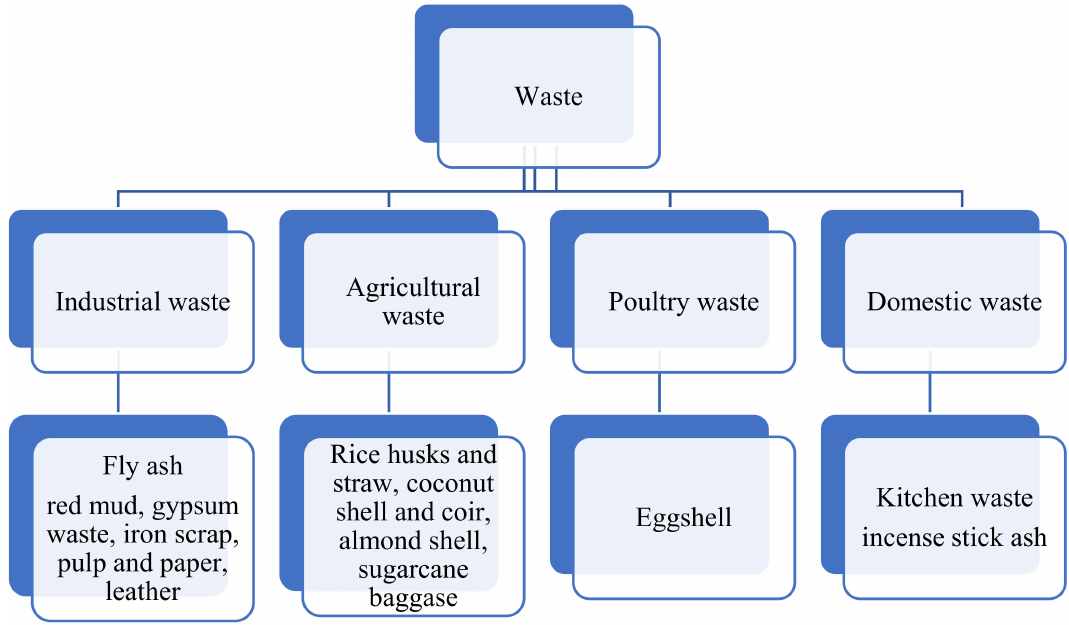
Figure 1. Classifications of the different valuable waste